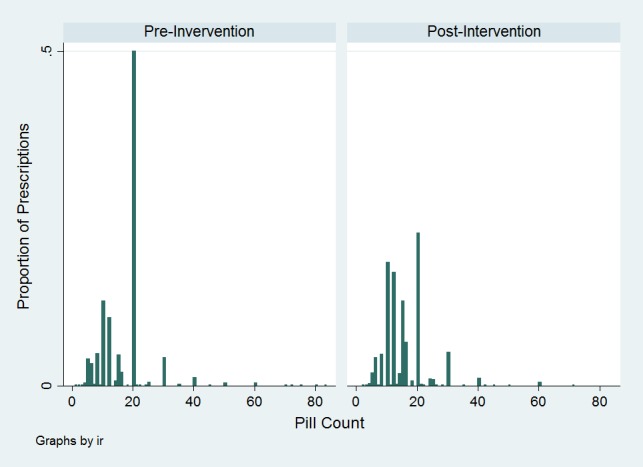
Histogram demonstrating number of tablets prescribed as a fraction of overall prescribed, opioid-containing analgesics before and after removal of default quantity of 20 tablets